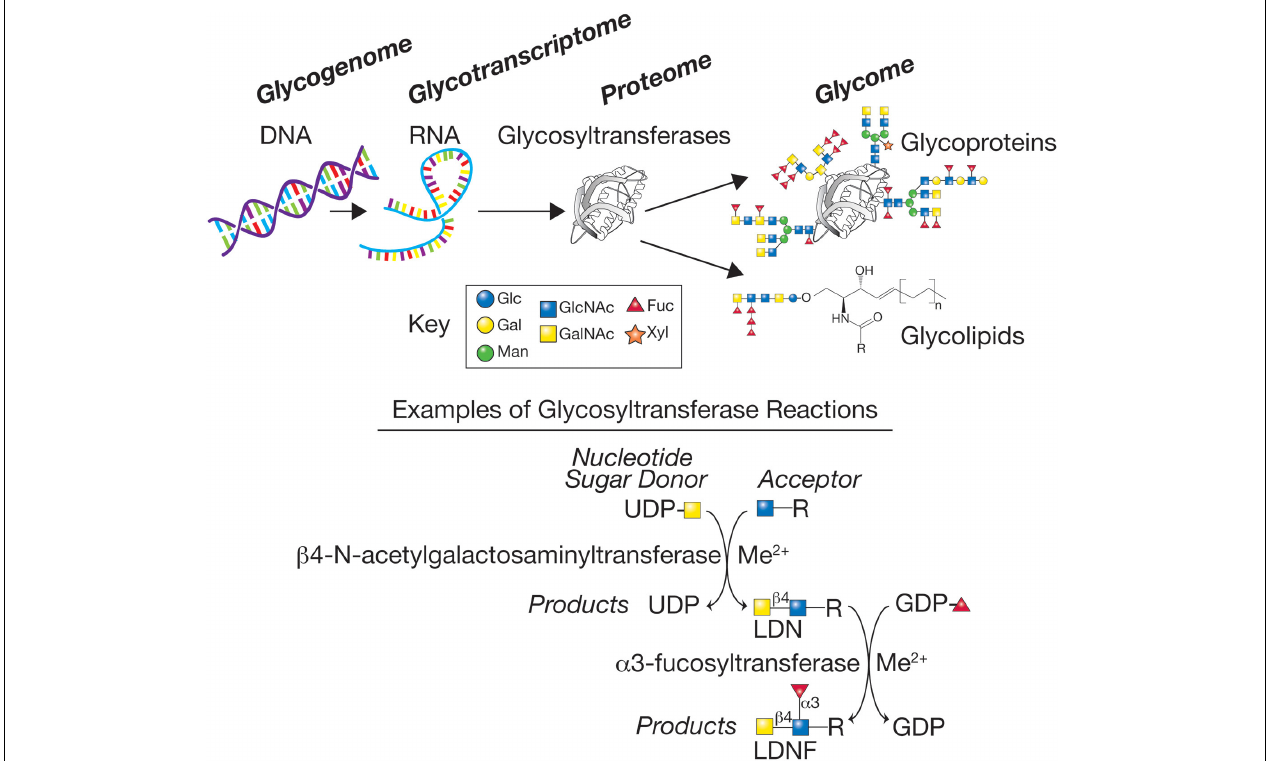
FIGURE 1 | The glycogenome represents the genes encoding the various glycosyltransferases, glycosidases, sugar, and nucleotide sugar metabolizing enzymes important in glycan biosynthesis, and nucleotide sugar transporters. The glycosyltransferases generated from the glycotranscriptome in schistosomes represent a large class of predicted enzymes, often requiring metal cofactors, such as manganese (Me 2 + ), that synthesize glycans using donor nucleotide sugars to form glycosidic bonds to acceptors, here represented by a sugar-R, where R = sugar, protein, or lipid to which a sugar is linked. The products of the